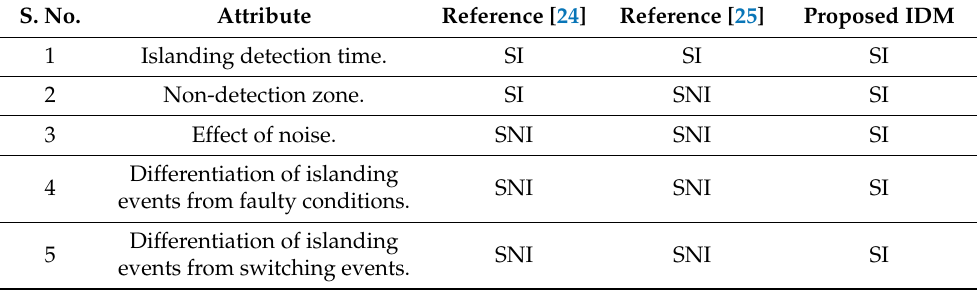
Table 5. Performance comparative study of islanding detection methods (IDMs). S. No.